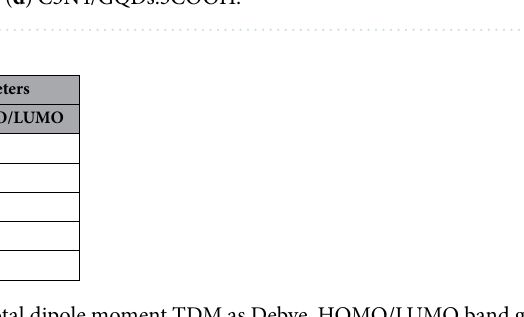
Table 1. B3LYP/LANL2DZ calculated total dipole moment TDM as Debye, HOMO/LUMO band gap energy as eV for the studied model molecules.